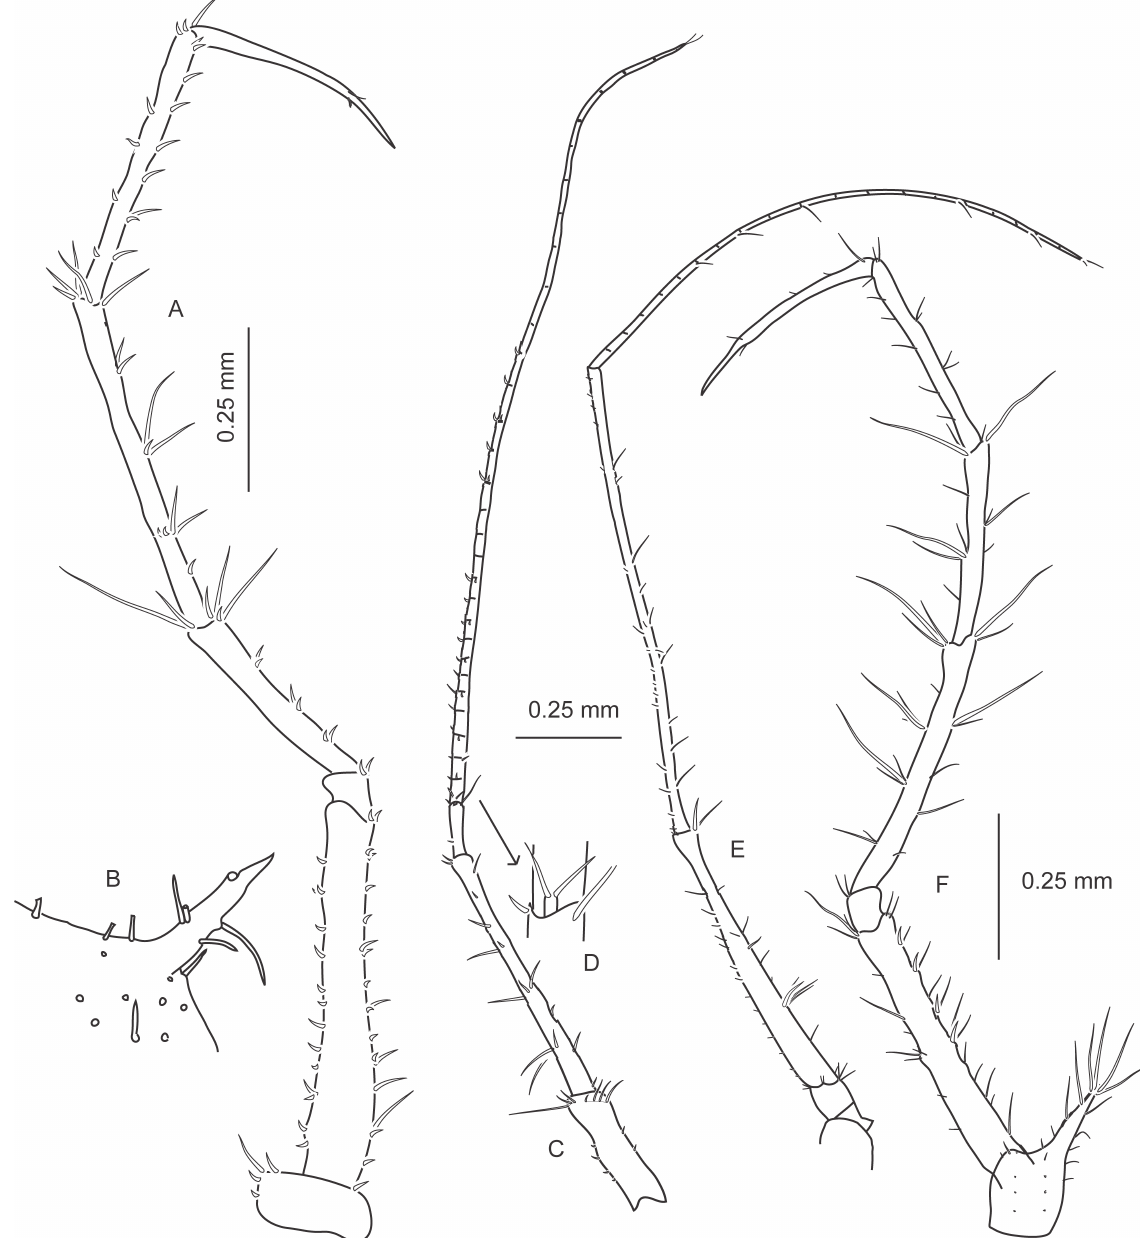
Fig. 15. Lepechinella victoriae sp. nov., holotype, ♀. A . Left P6. B . Tooth of peraeon segment 7. C . Female A1. D . Accessory flagellum. E . Female A2. F . Left